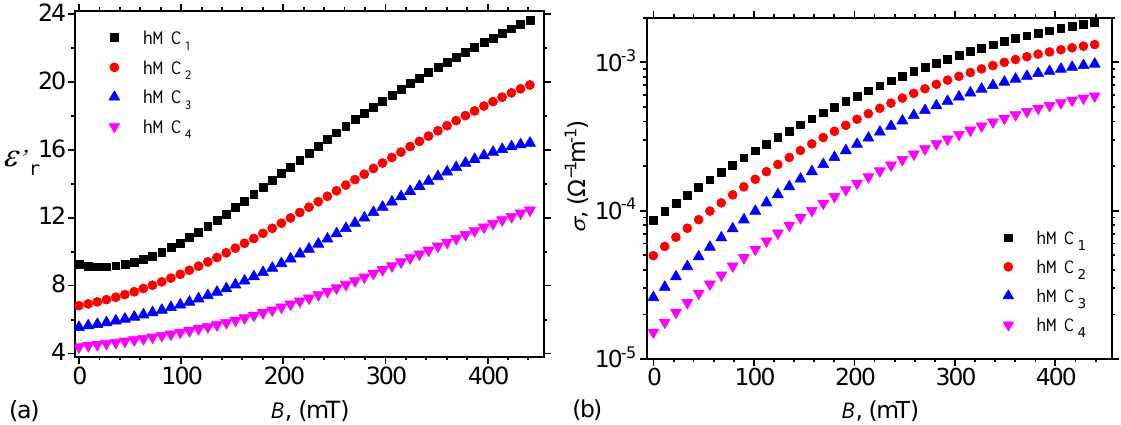
Figure 11. Relative dielectric permittivity (cid:101) (cid:48) r ( a ) and electrical conductivity σ ( b ), as a function of magnetic flux density B